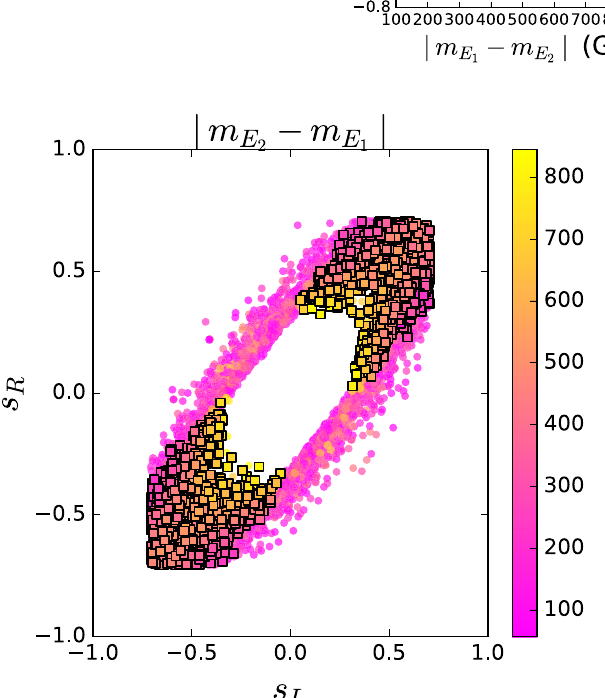
Fig. 4 All the samples explaining the muon g − 2 anomaly while satisfying the constraints of “pre ( g − 2 ) μ ”. The varying colors in each panel indicate the values of , m ) and s min ( m E E 2 L , and the 1 min ( m i , m j ,...) denotes the minimal value of m i , m j ,...